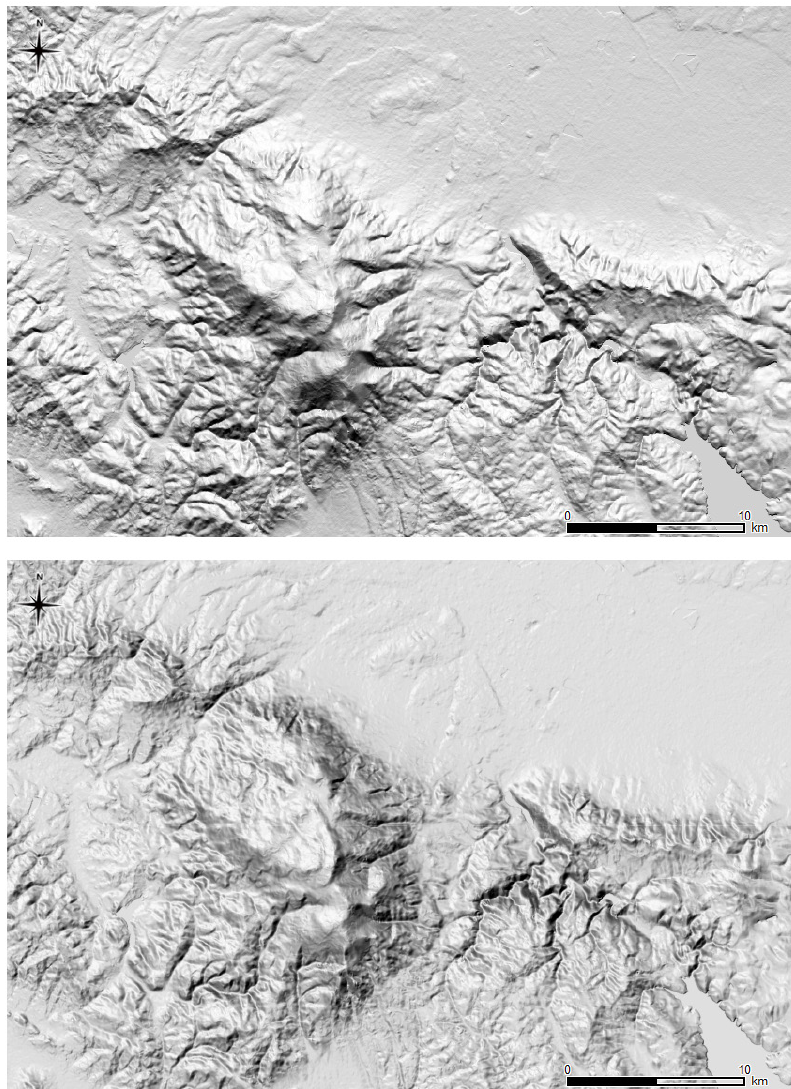
Fig. 2. Two-directional hillshade (top) and multidirectional oblique-weighted hillshade